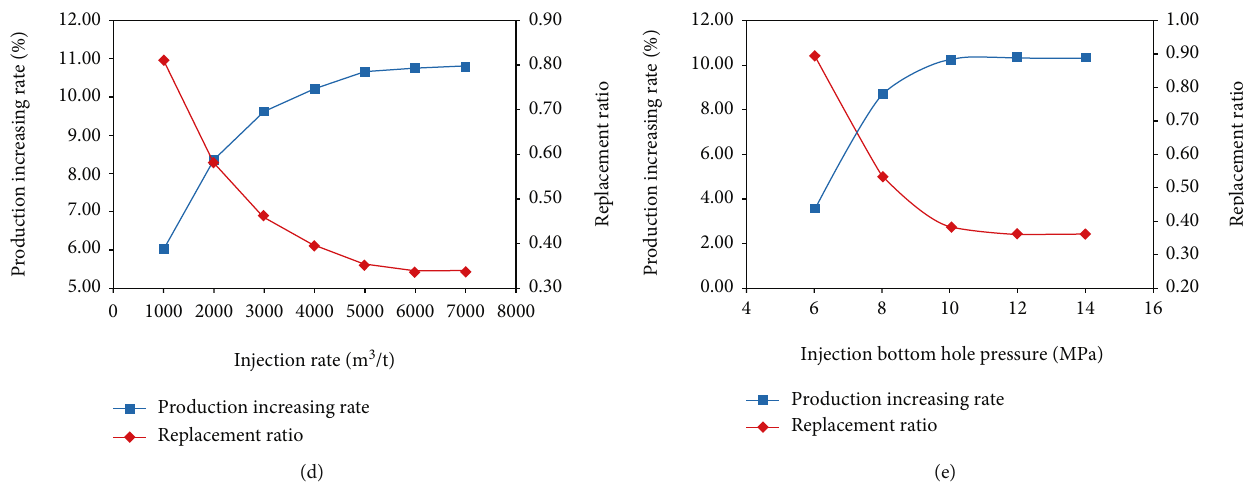
Figure 6: (a – e), respectively, describe the production increasing rate and replacement ratio of production injection well spacing, gas injection timing, gas injection duration, gas injection rate, and the bottom-hole injection